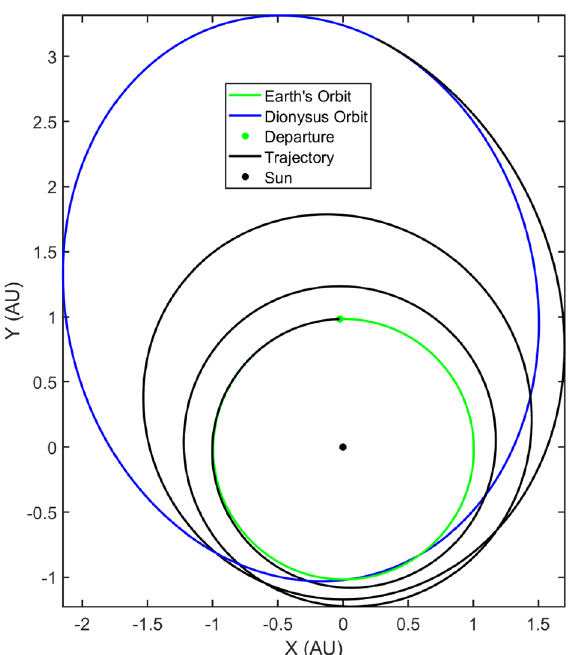
Figure 1. Earth-3671 dionysus time-optimal nominal